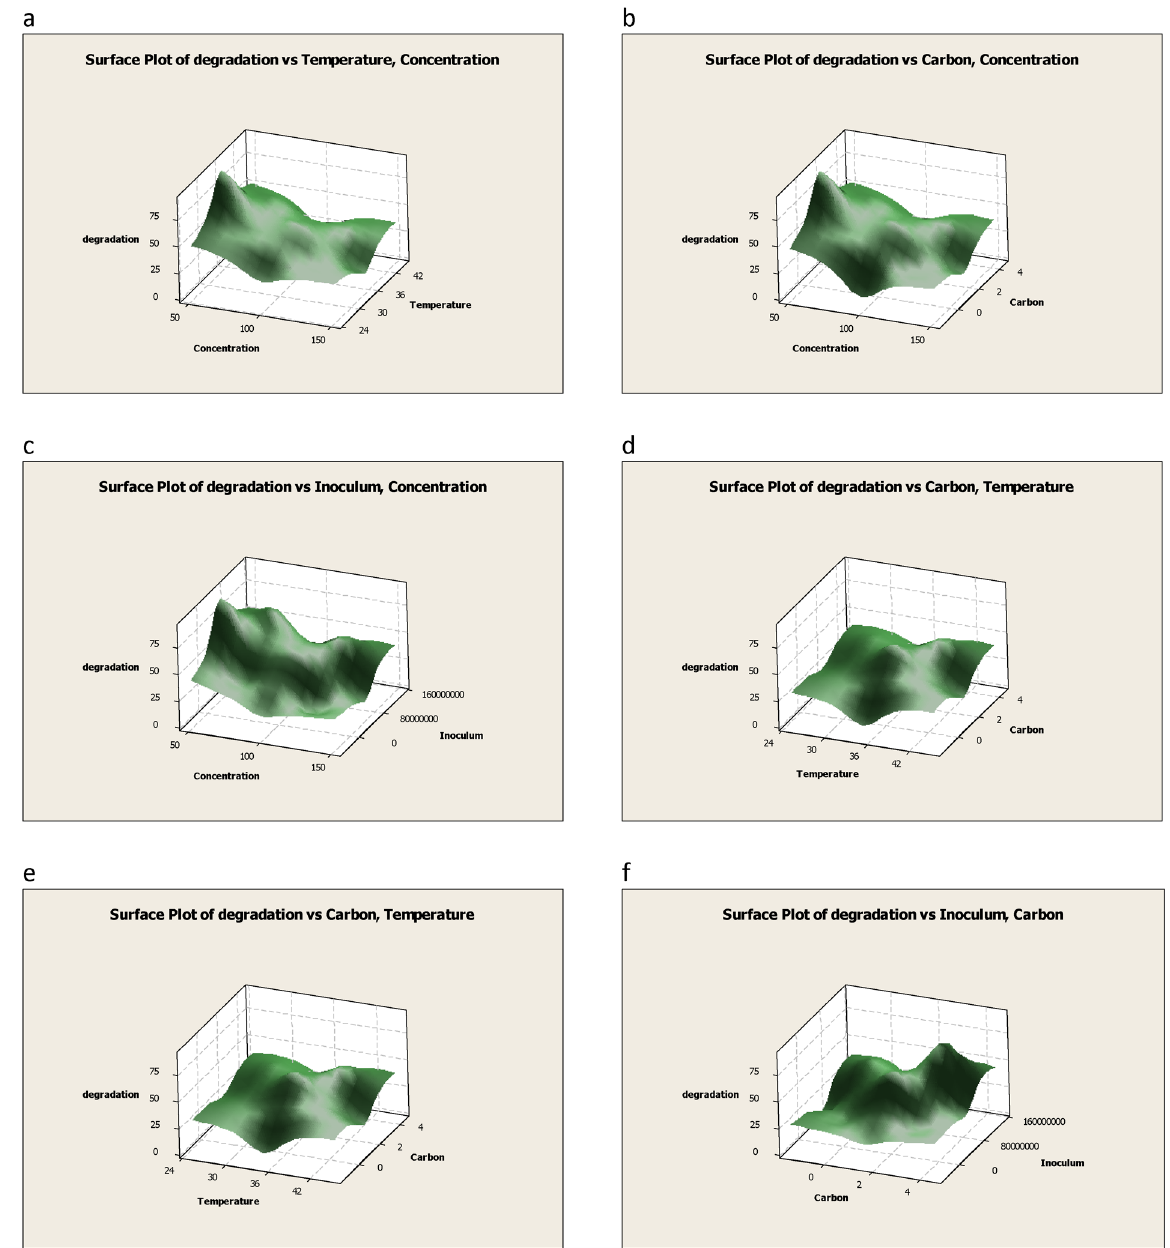
Figure 6. Surface plot showing interaction between different variables. ( a ) Interaction between degradation, temperature and chlorpyrifos concentration. ( b ) Interaction between degradation, carbon source and chlorpyrifos concentration. ( c ) Interaction between degradation, inoculum size and chlorpyrifos concentration. ( d ) Interaction between degradation, carbon source and temperature. ( e ) Interaction between degradation, carbon source and temperature. ( f ) Interaction between degradation, inoculum size and carbon